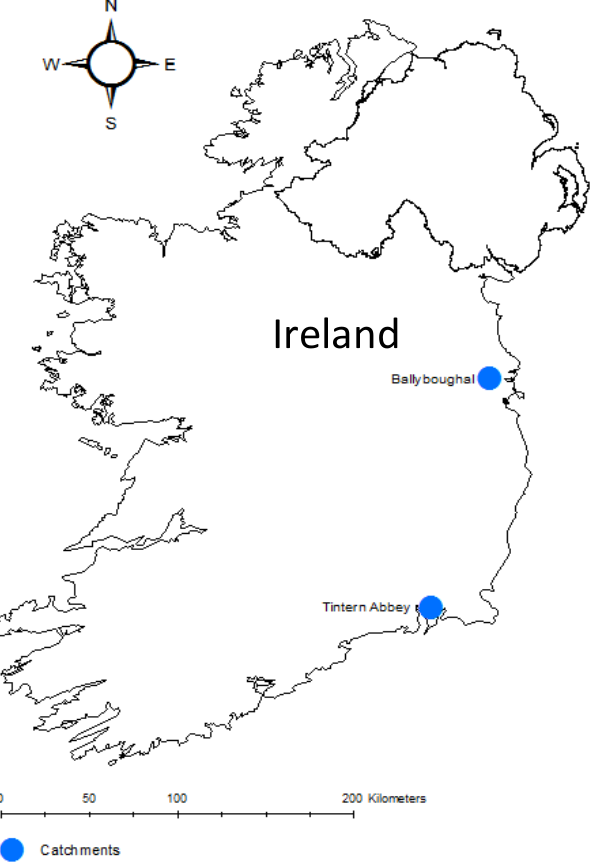
Figure 1. Location of the Ballyboughal (BB) and Tintern Abbey (TA) catchments in Ireland.